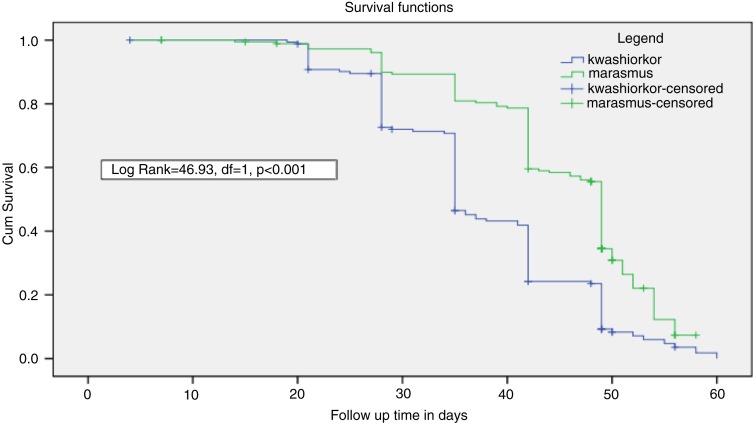
Comparison of survival curve for children with kwashiorkor and marasmus treated at OTP.